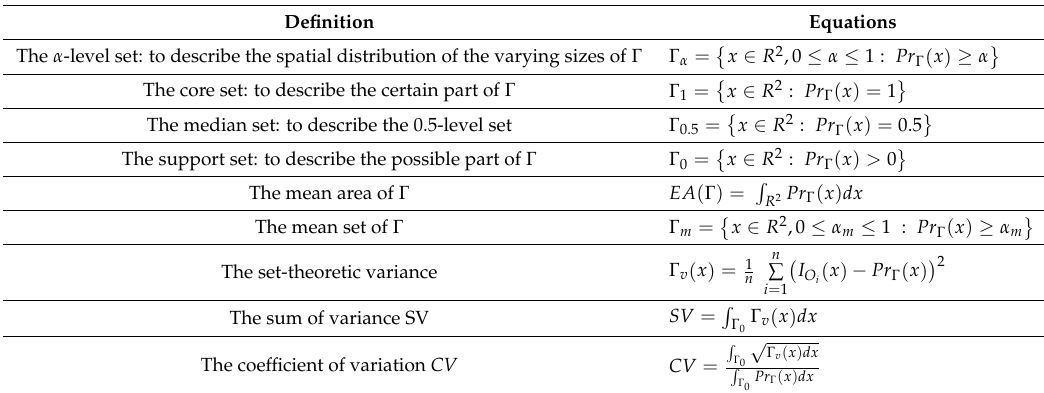
Table 2. The statistical parameter of random